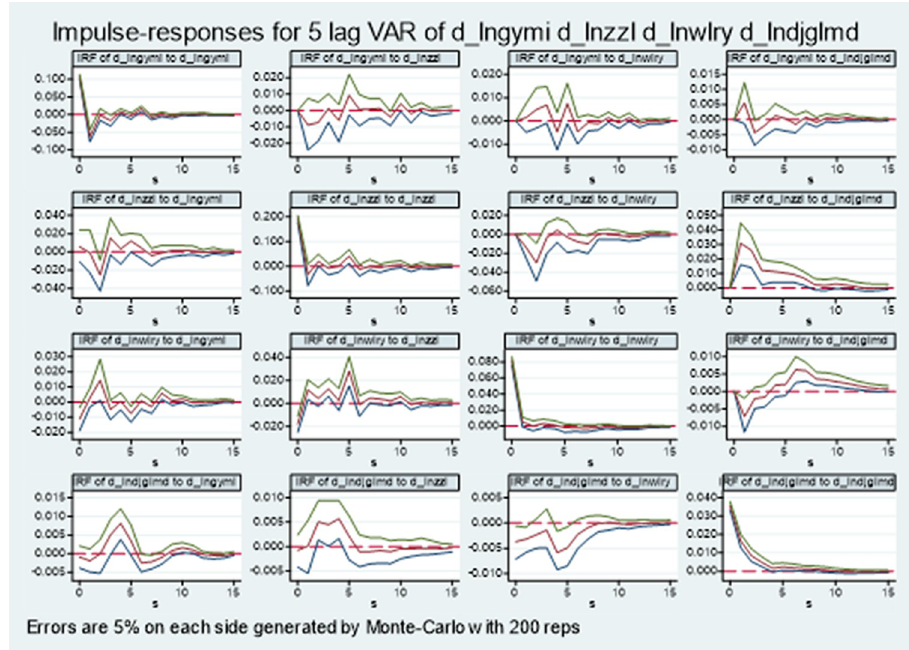
Fig 3. Impulse response diagram of logistics industry and manufacturing